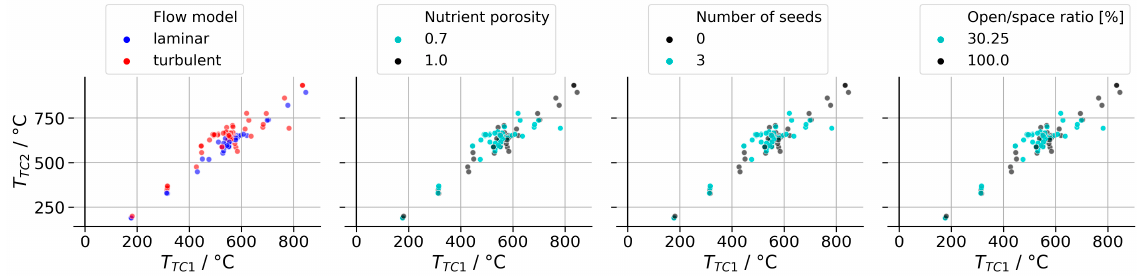
Figure 4. Overview of generated simulation data. Data are split by different features in the subplots as indicated by the legends. Darker regions indicate overlap of datapoint symbols. Cyan symbols represent cases with internal solids, black datapoints indicate cases without solids inside the autoclave.